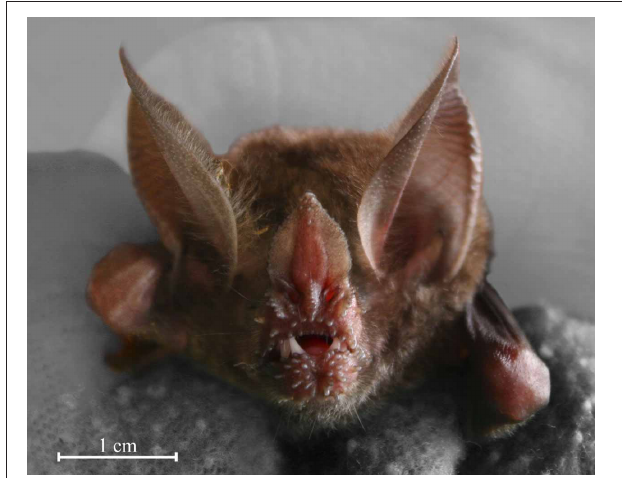
FIGURE 1 | Trachops cirrhosus has a nose leaf with a lancet that is 9mm from tip to nostrils. The large ears and the characteristic tubercles around the chin and lips are also clearly